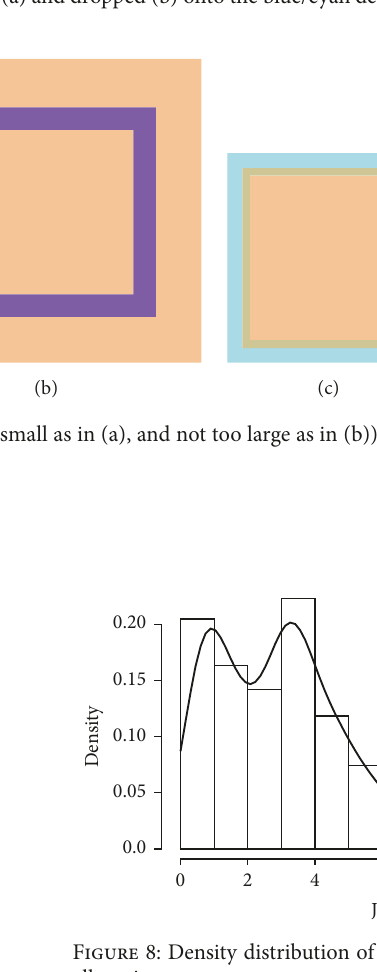
Figure 5: The red circle needed to be dragged (a) and dropped (b) onto the blue/cyan destination circle.